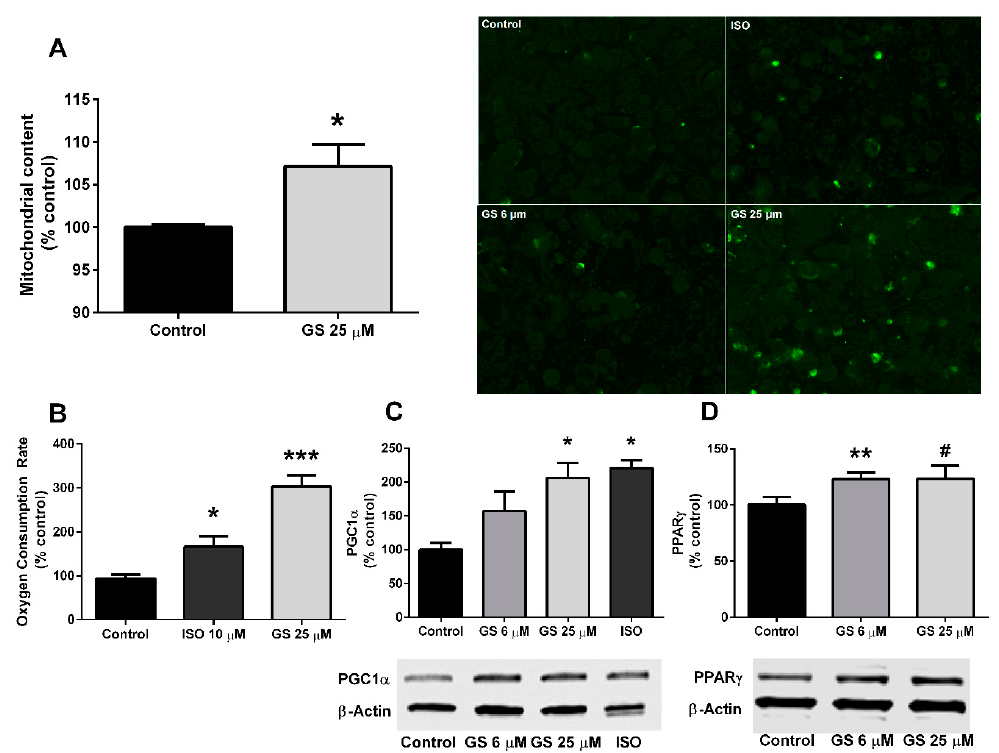
Figure 3. GS treatment in 3T3-L1 adipocytes induces mitochondrial biogenesis. GS treatment increases mitochondrial density (20 × objective) ( A ), oxygen consumption rate ( B ), and markers of mitochondrial biogenesis ( C and D ). Data presented as mean ± SEM from n = 3–6 replicates per group. # p < 0.10, * p < 0.05, ** p < 0.01, *** p < 0.001 vs. control. Abbreviations: isoproterenol (ISO), peroxisome proliferator-activated receptor gamma coactivator 1-alpha (PGC1 α ), peroxisome proliferator-activated receptor gamma (PPAR γ ).